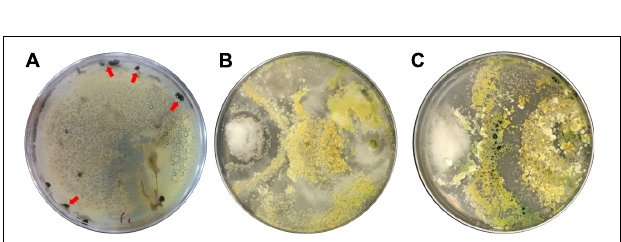
FIGURE 7 | The in vitro antagonism assays using T. harzianum against the phytopathogenic fungus S. sclerotiorum (white mold). (A) Results obtained with the unencapsulated fungus, showing that the fungus was able to control the phytopathogen, according to the classification scale (Bell et al., 1982), but that there was the formation of white mold sclerotia (indicated by the arrows). (B) Results using the fungus encapsulated in wet microparticles. (C) Results using the fungus encapsulated in dried microparticles, indicating that the encapsulated fungus was a satisfactory